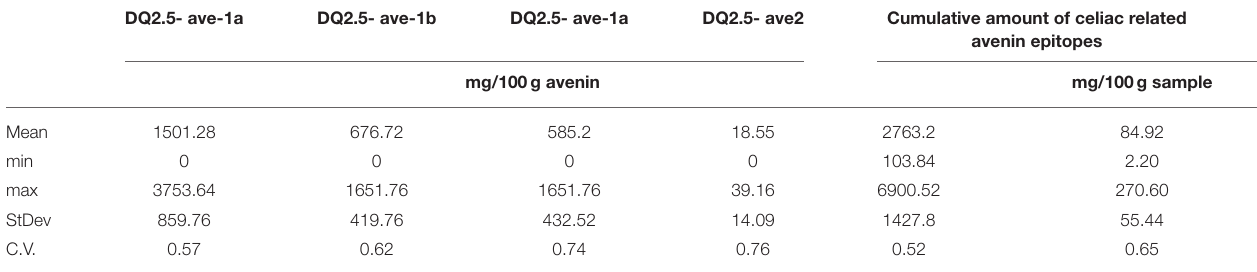
TABLE 3 | Variation of the amounts of celiac-related avenin epitopes among 106 oat samples.